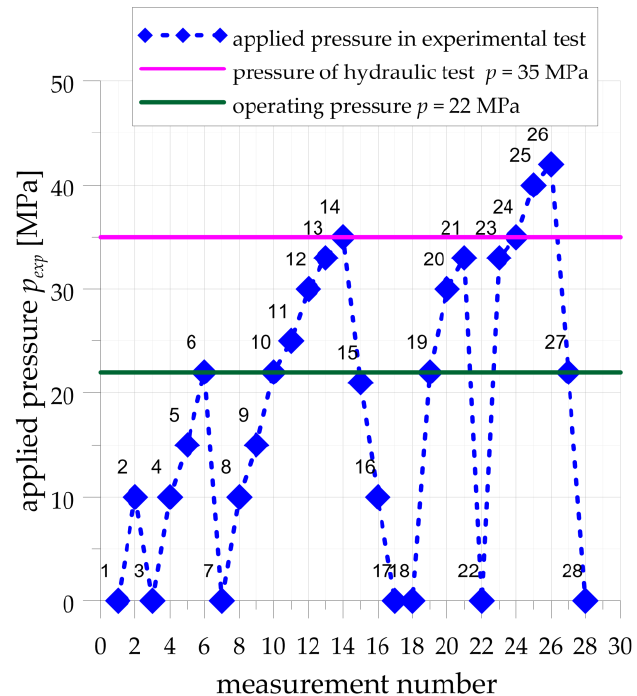
Figure 7. Applied load cycles with nominal values of internal pressure and number of measure- ment points.